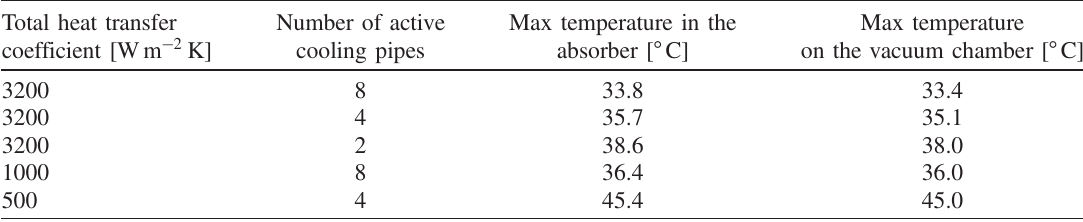
TABLE IV. Summary of the cooling simulation